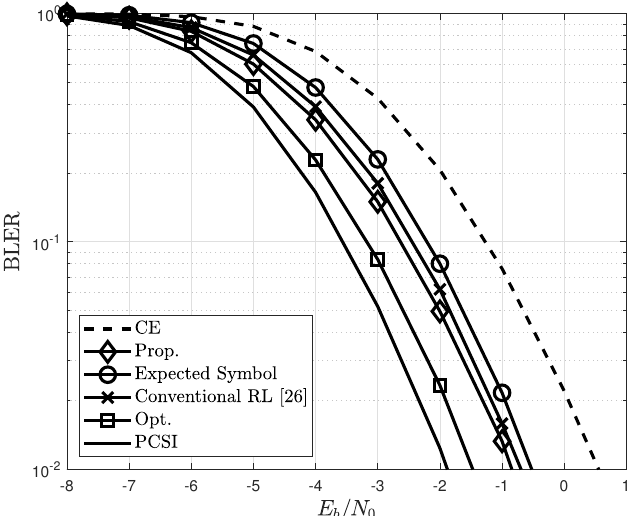
Figure 5. BLERs of conventional and proposed channel estimators for the different